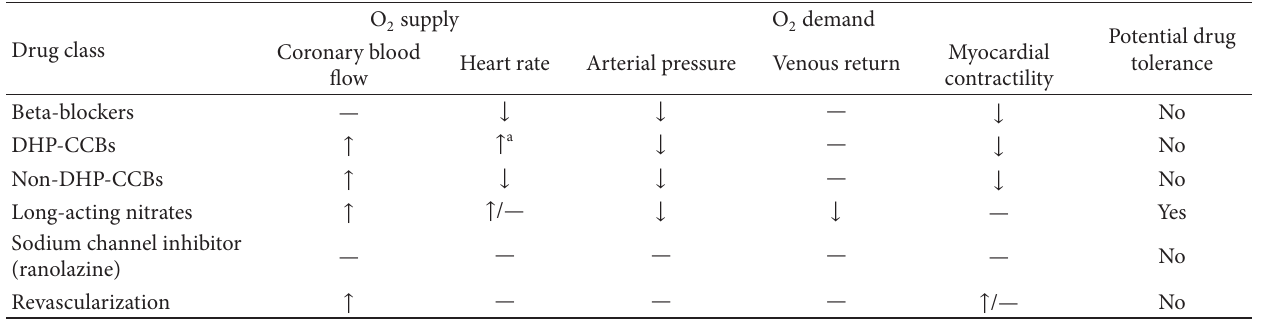
Table 4: Effect of antianginal treatments on myocardial oxygen supply and